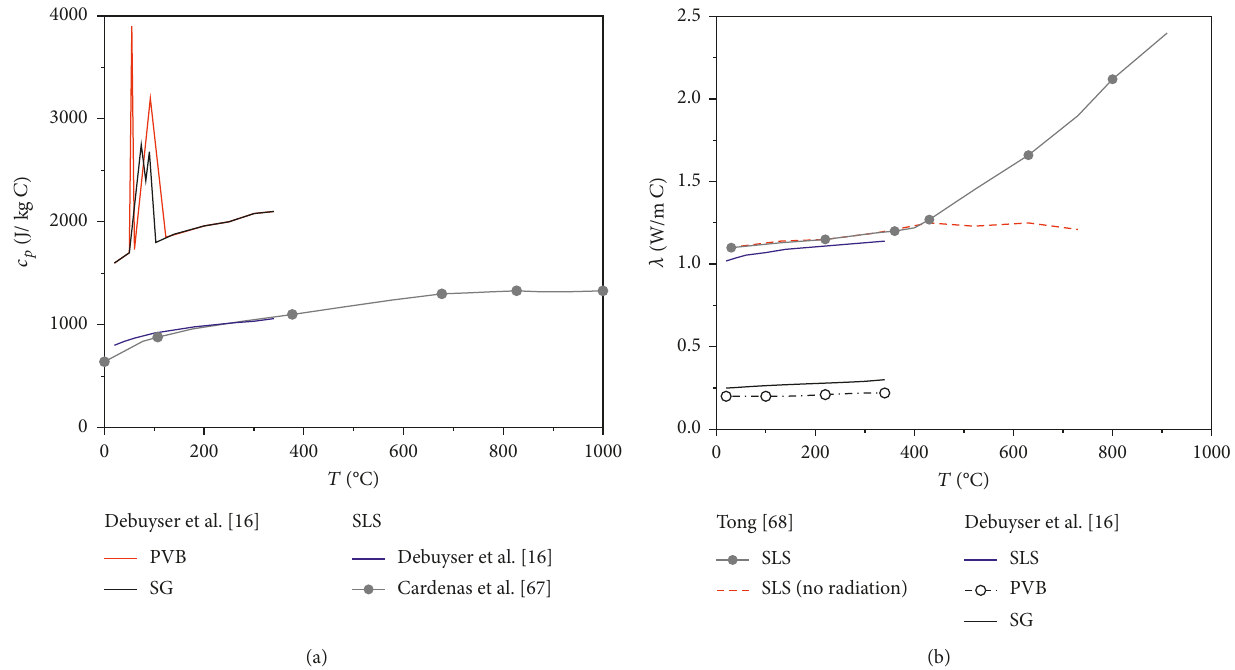
Figure 8: Thermal properties of glass, as a function of temperature, as derived from several literature references. (a) Specific heat capacity and (b) thermal